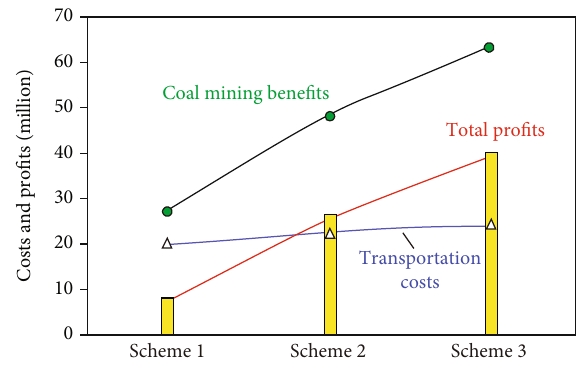
Figure 6: Comparison of the economic bene fi ts of di ff erent